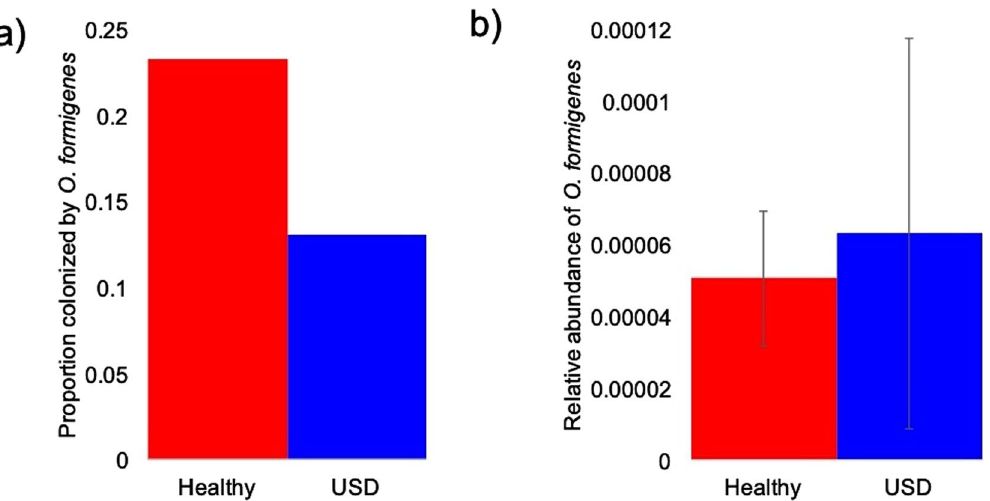
Figure 4. Metrics associated with Oxalobacter formigenes between healthy and USD groups. ( a ) Colonization rate of O. formigenes between groups. Significance was determined by a relative risk test, followed by a post-hoc Fisher’s exact test (p > 0.05); ( b ) Relative abundance of O. formigenes . Significance was determined by a student’s t-test (p >